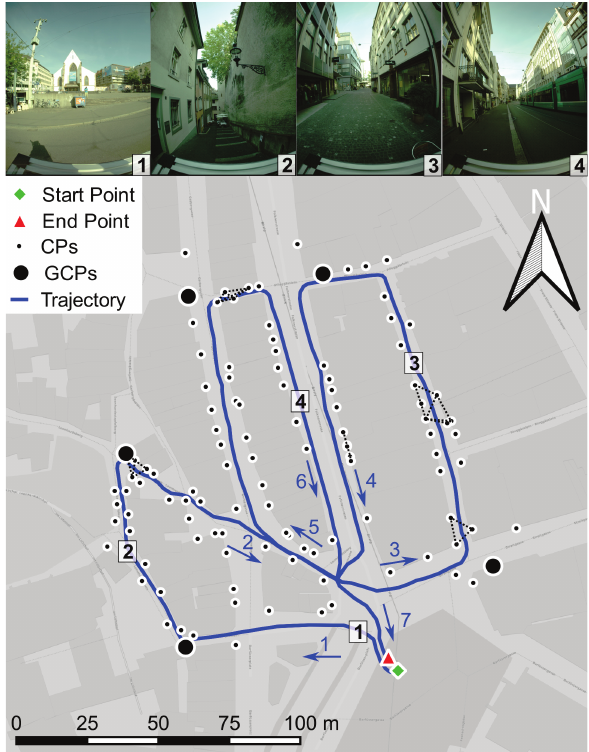
Figure 3. Map from the first test site located in the city centre of Basel with images showing environmental conditions.